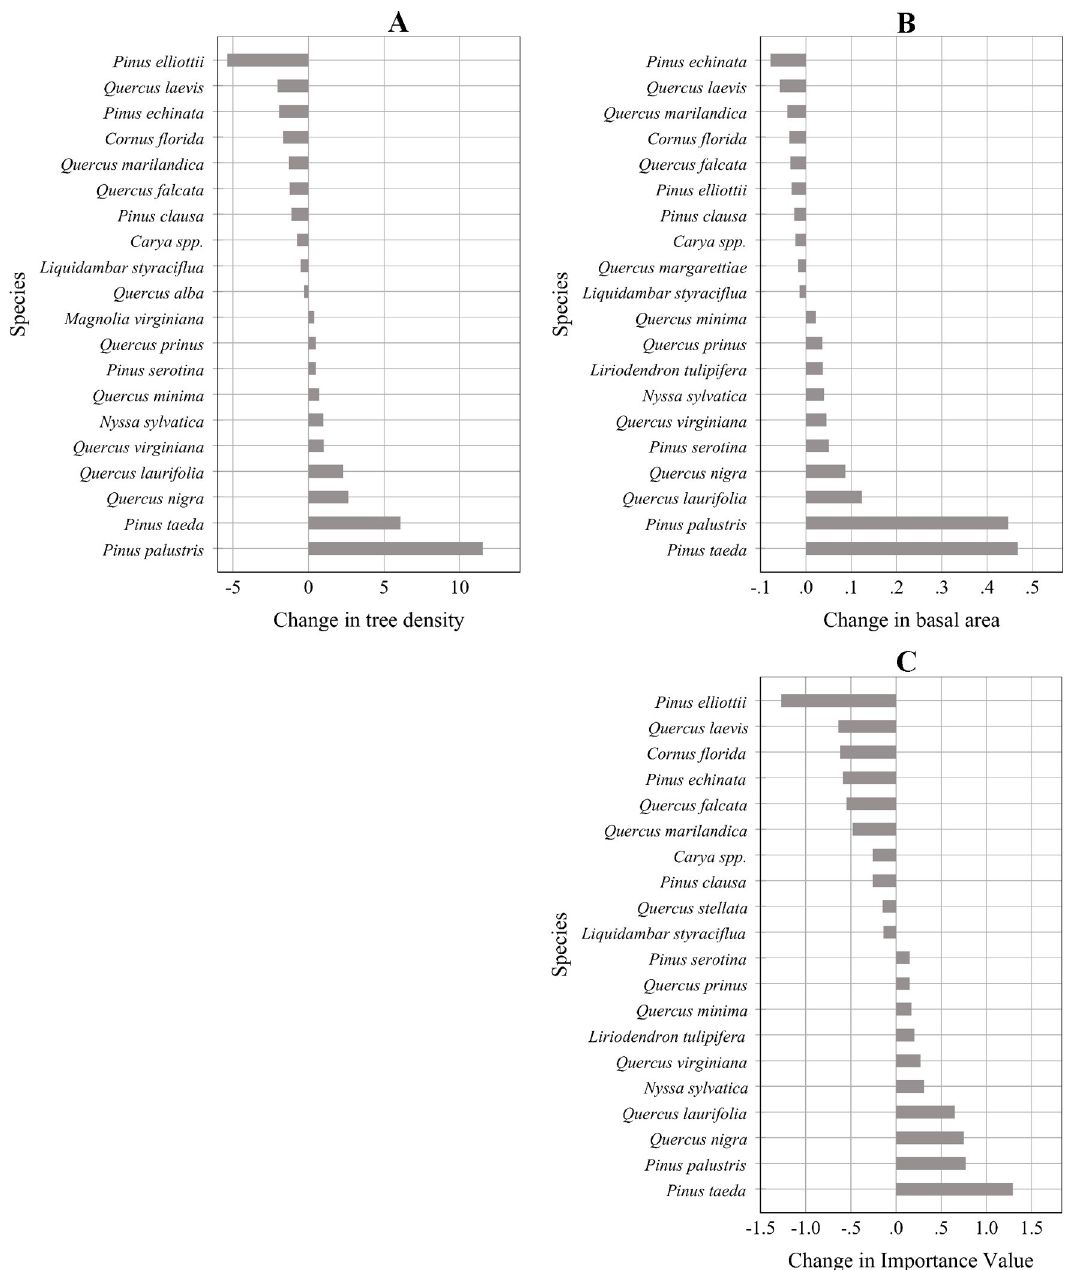
Fig 5. Ten species with the greatest increase and ten species with the greatest decrease in (A) tree density (stems ha -1 ), (B) basal area (m 2 ha -1 ), and (C) Importance Value (%) across the plots between 2004 and 2011, where 2004 and 2011 are the centroid-year of first (1997–2010) and last (2003–2018) inventory intervals,